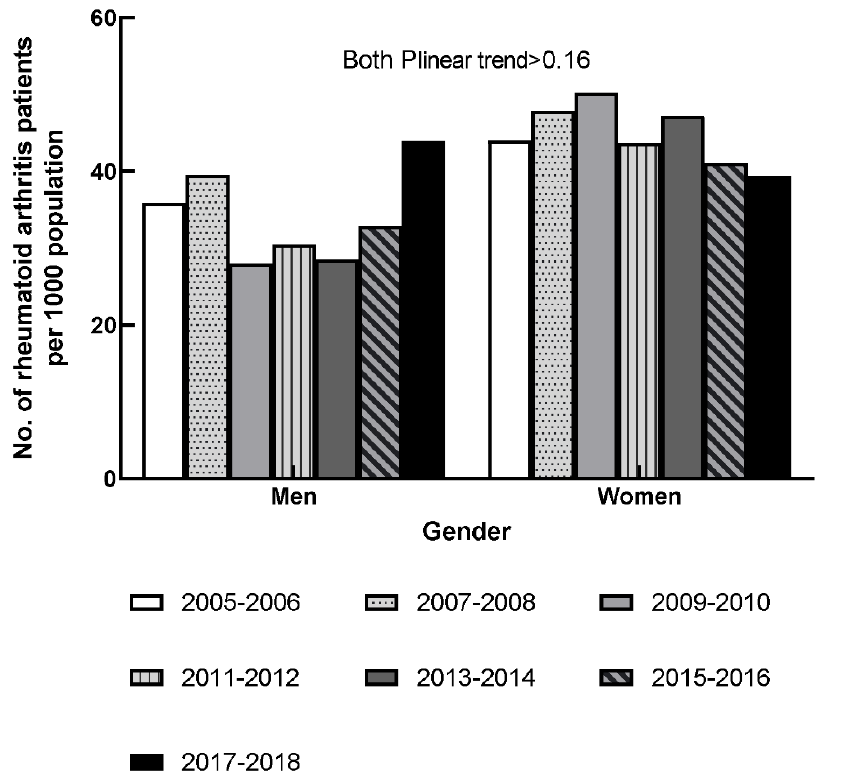
Figure 1. Age-adjusted prevalence of rheumatoid arthritis by gender, 2005–2006 through 2017–2018.